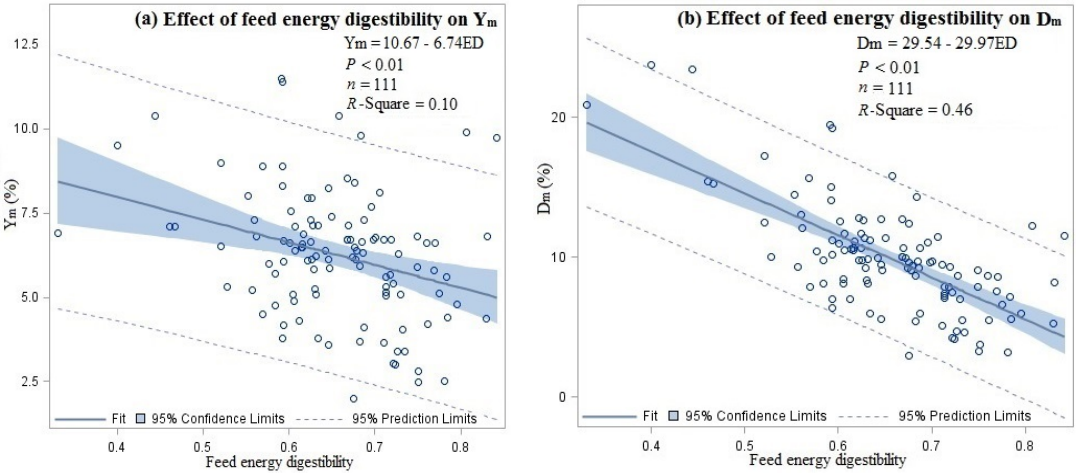
Figure 6. Fit plots for ( a ) Y m (CH 4 loss as a percentage of GEI) and ( b ) D m (CH 4 loss as a percentage of digestible energy intake) as a function of feed energy